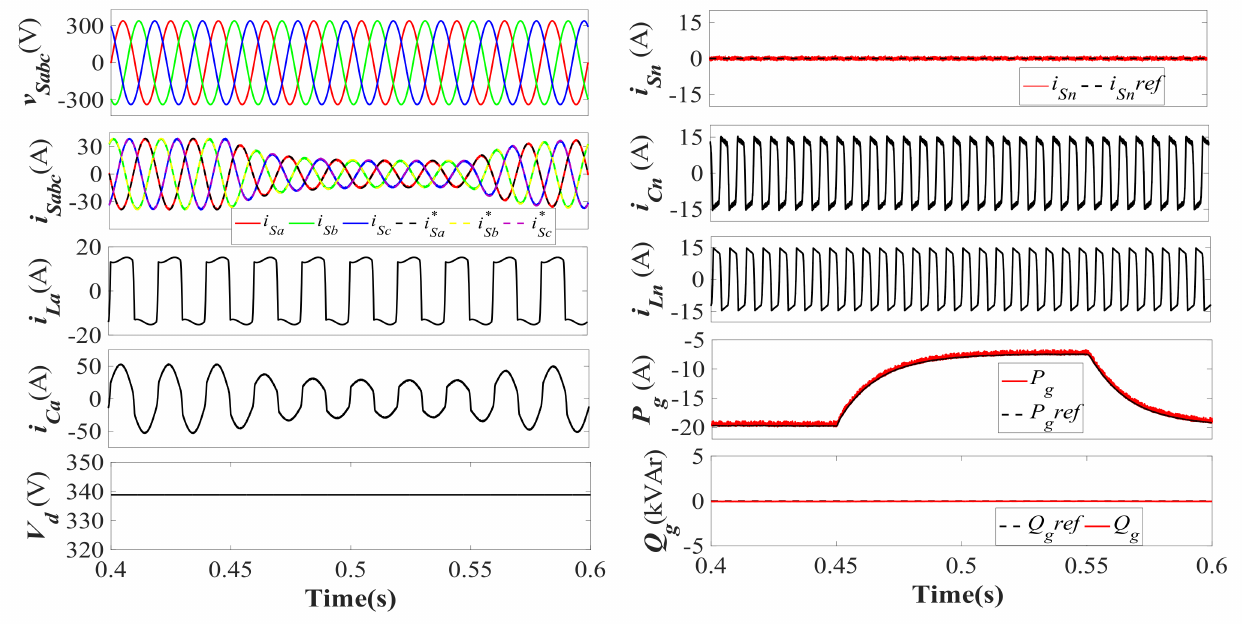
Figure 6. Dynamic performance during insolation variation of v sabc , i sabc , i Ca , V d , i La , i Sn , i Cn , i Ln , P g , and Q g